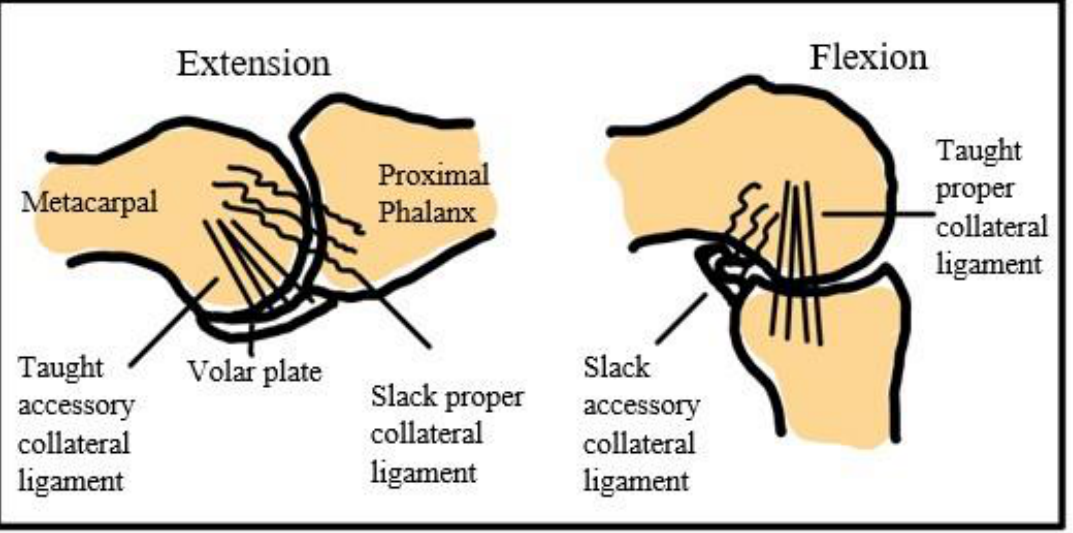
Figure 2. Finger joint and ligament.